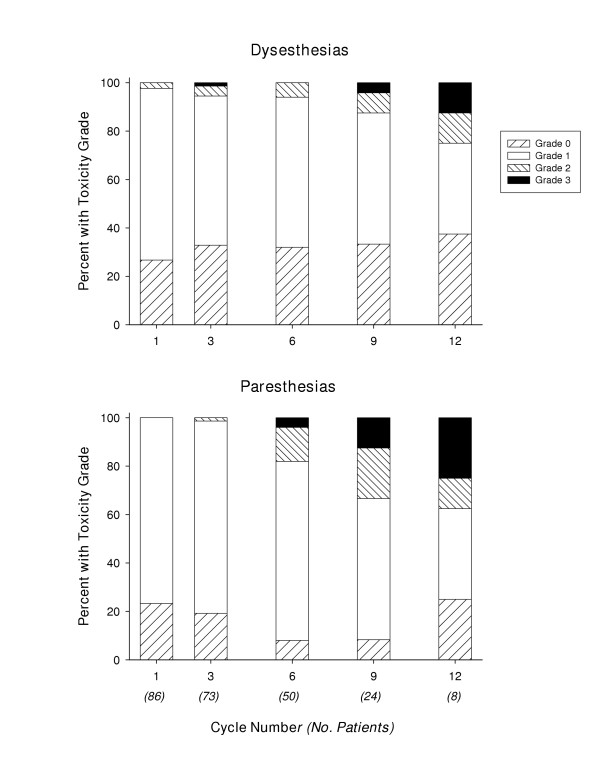
Percentage of subjects with dysesthesias/paresthesias as a function of number of cycles. The number of subjects at each cycle is shown in parentheses.